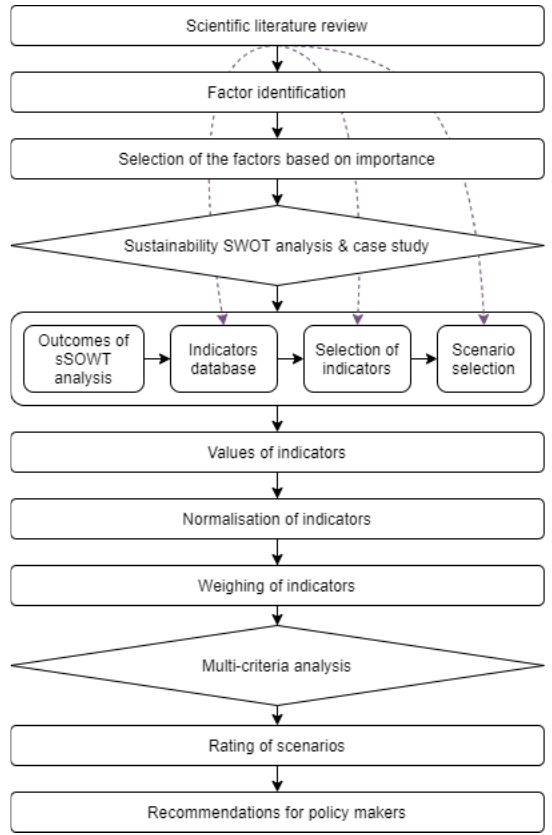
Fig. 1. Concept of the overall